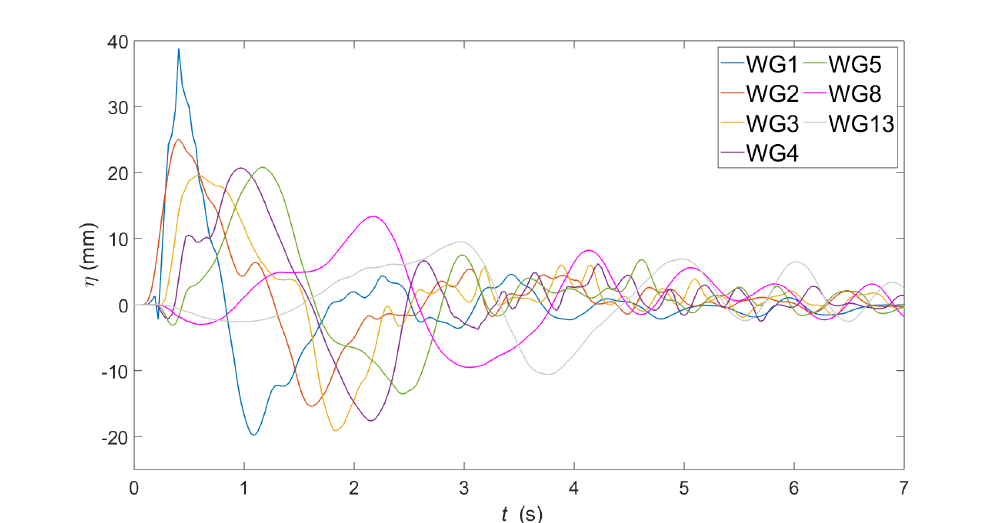
Figure 8. Surface elevation η time histories for an inclined uplift test of 60 mm in 370 mm water